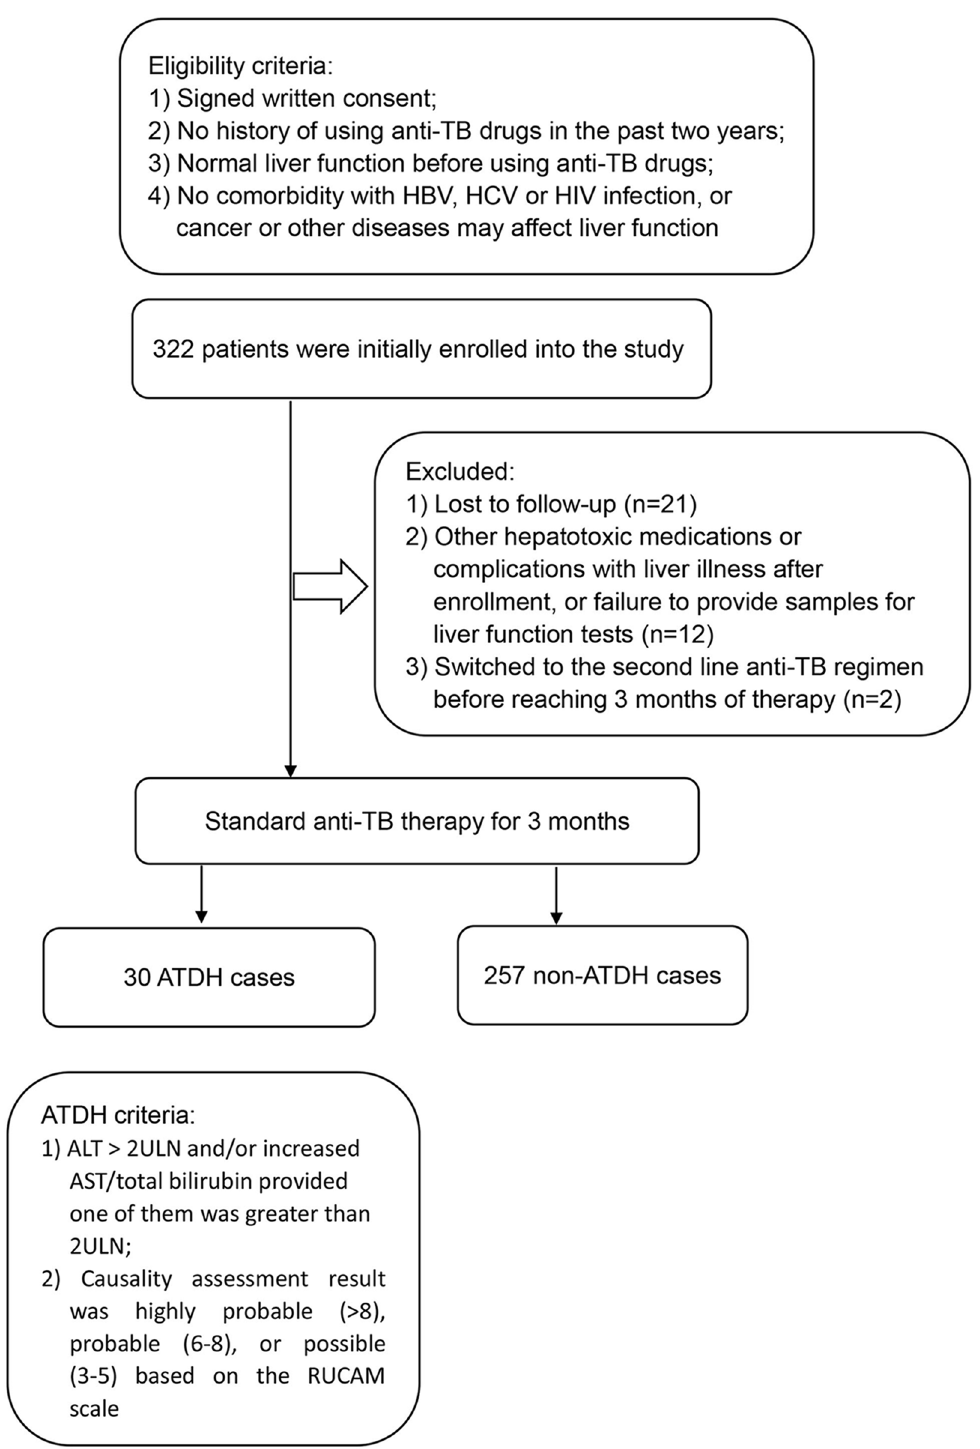
Fig 1. Overall study plan and ATDH outcome stating the inclusion and exclusion criteria in the prospective study.